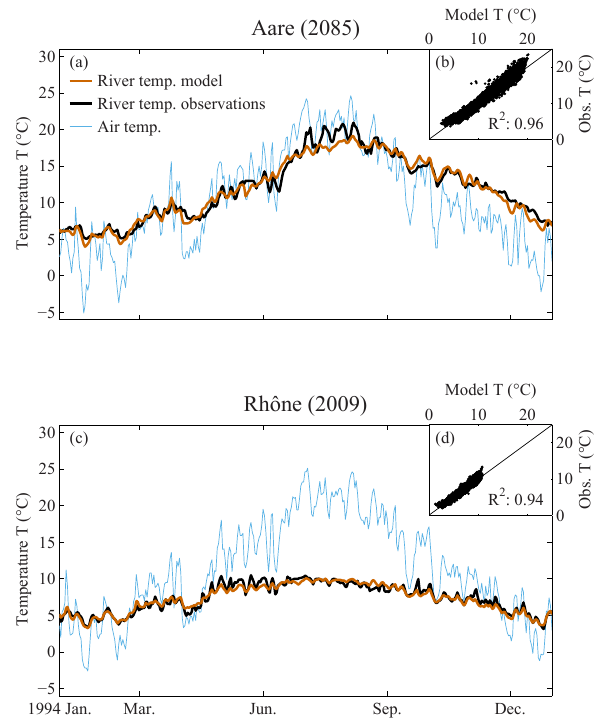
Figure 3. air2stream modeled (orange) and measured (black) tem- perature ( T ) compared to air temperature (blue) for (a) Aare River and (c) Rhône River in 1994. The insets (b) and (d) show modeled versus observed temperature from 1990 to 2009 with coefficient of determination ( R 2 )